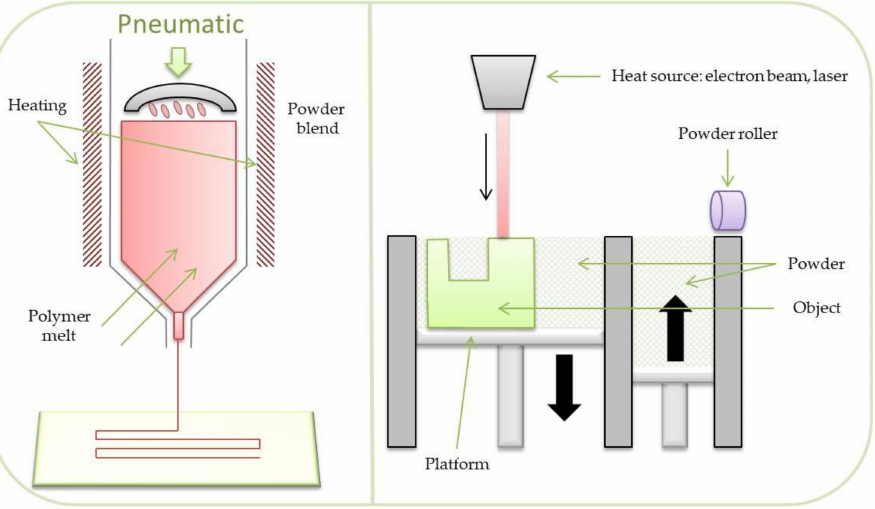
Figure 5. Scheme illustration of direct 3D printing technique (left) and “drop on powder tech- nique”